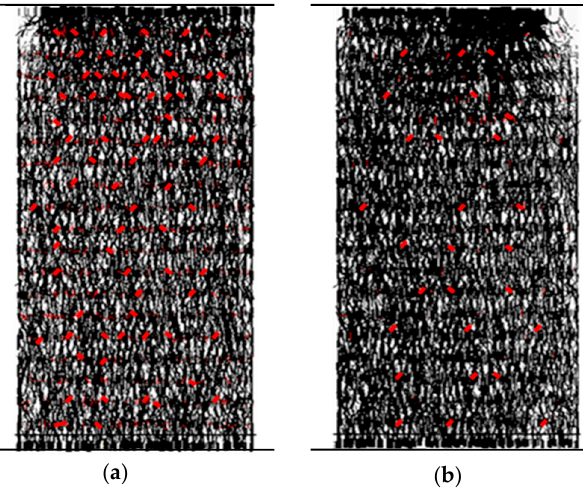
Figure 19. UCS variation of transversely isotropic rock samples with different joint shear stiffness.